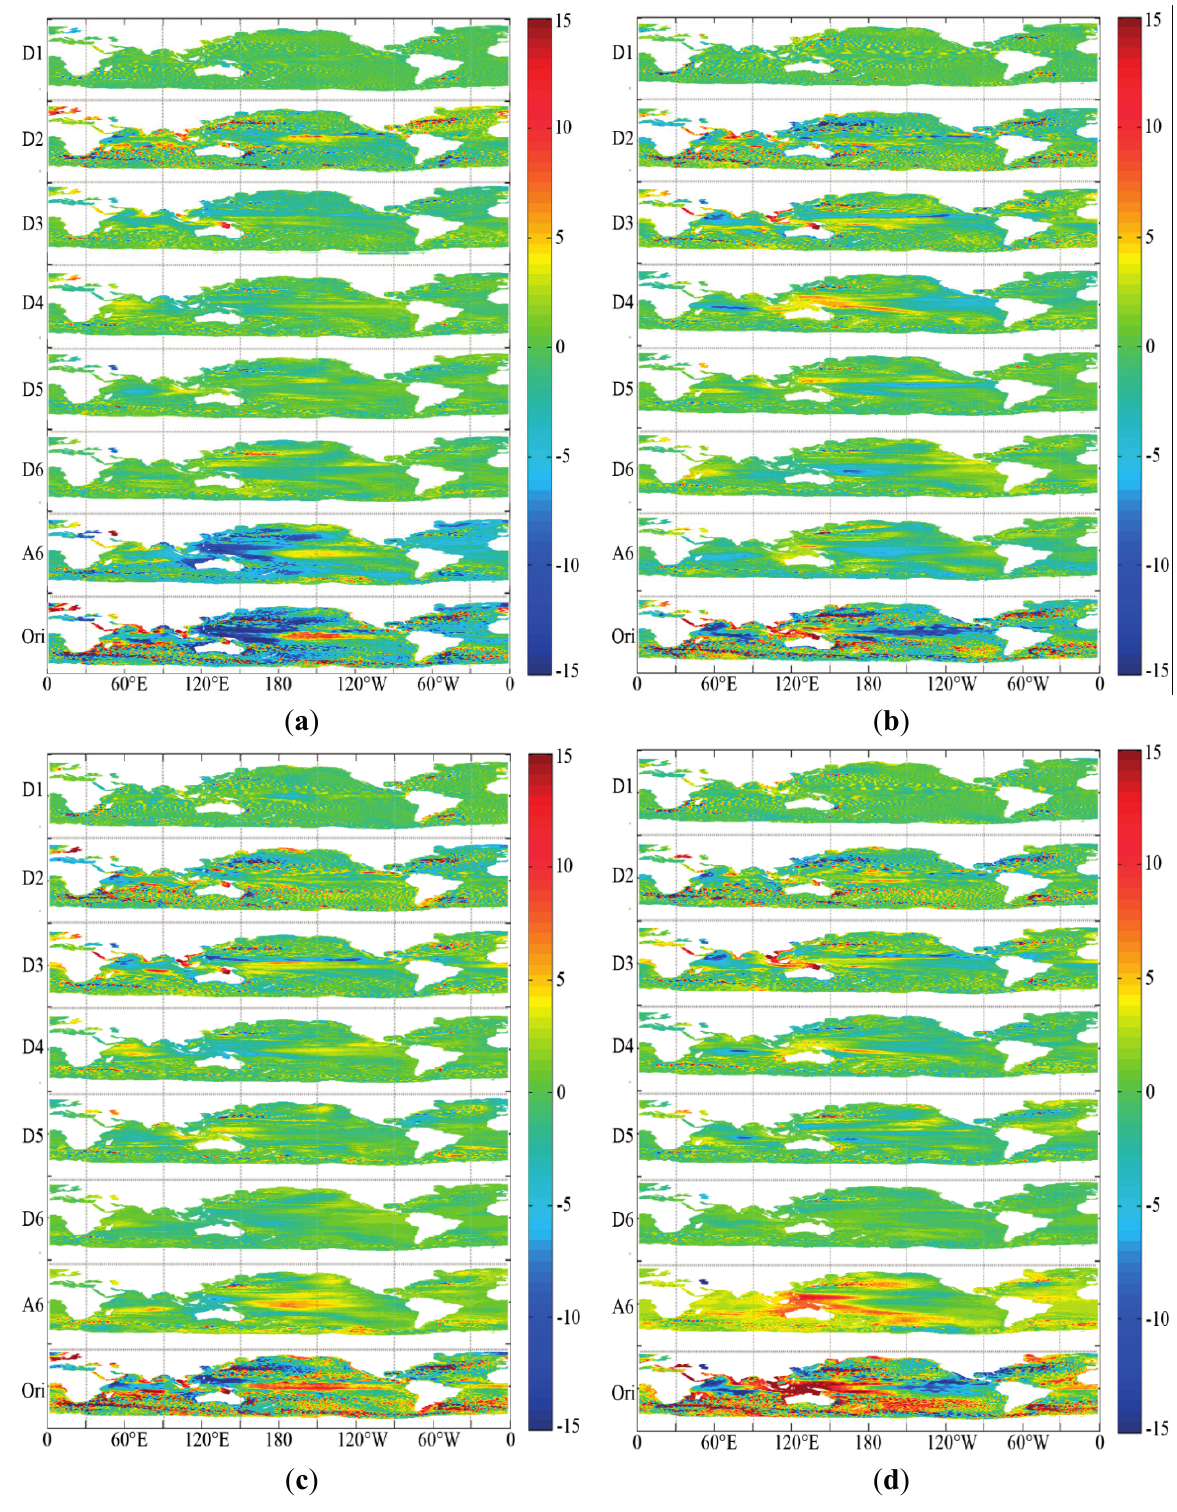
Figure 3. The multi-signal wavelet decomposition results. Four time slices are selected from the whole spatio-temporal data cubes of original data and reconstructed decomposed components (( a ) January 1993; ( b ) January 1999; ( c ) January 2005; ( d ) January 2011). The color bar in each subgraph indicates anomaly range of the data. The multi-signal wavelet decomposition not only filters the data in the temporal domain, but also affects the spatial domain. Larger temporal scales will also result in a smoother spatial